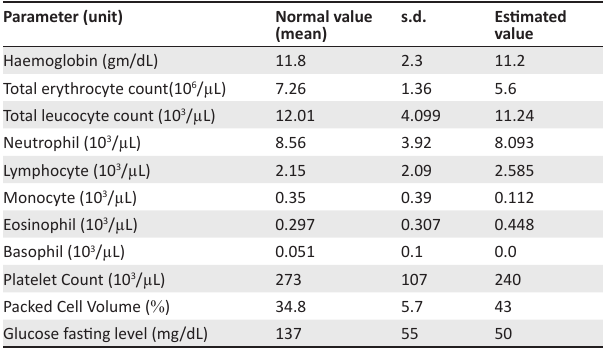
TABLE 1: Comparison of preoperative haemogram of 22-year-old male jaguar with available mean values. Parameter (unit) Normal value